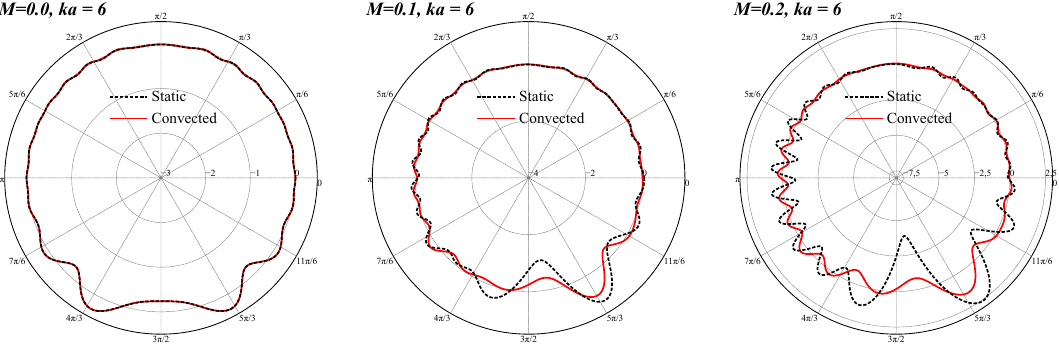
Figure 9. Directivity pattern at r = 5 R 2 of the insertion loss I Mach number M b = 0.0,0.1,0.2.